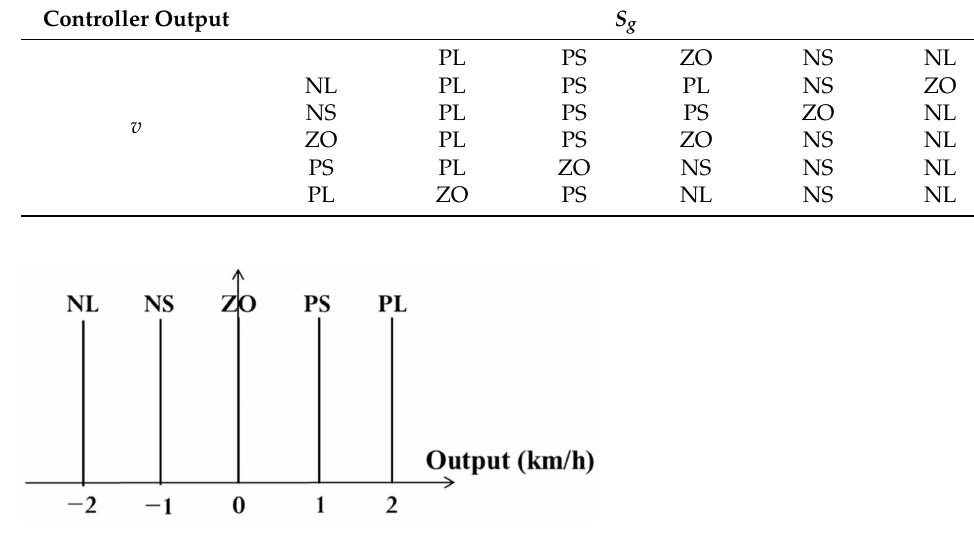
Figure 7. Output membership